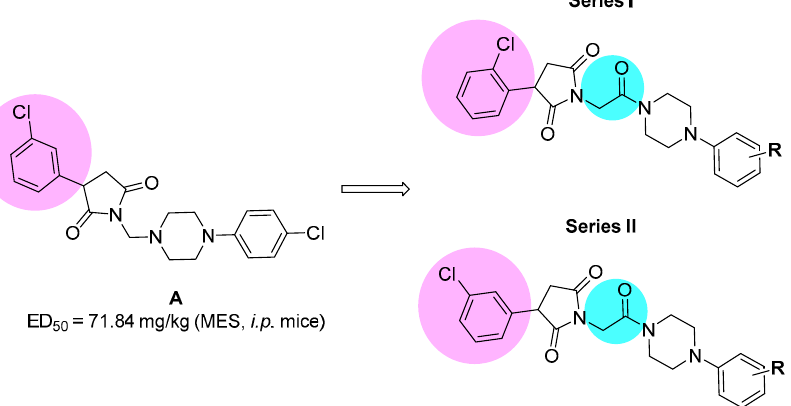
Figure 1. The chemical prototype A [8] synthesized previously, and proposed structural modifications for compounds reported in the current studies.